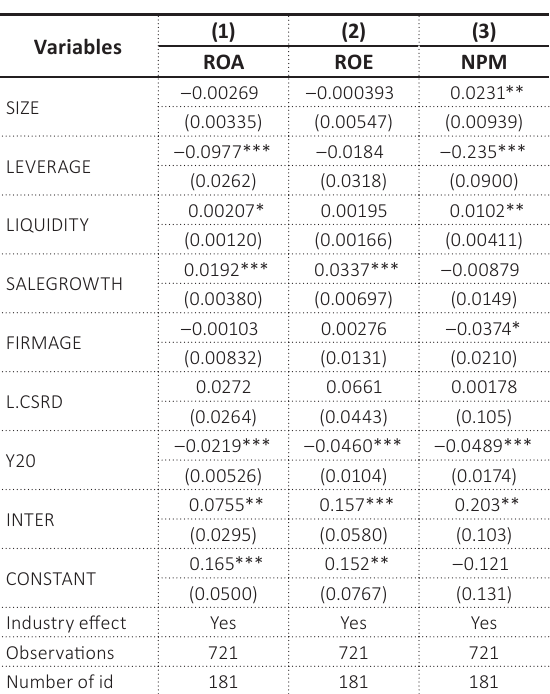
Table 9. Regression results of regression